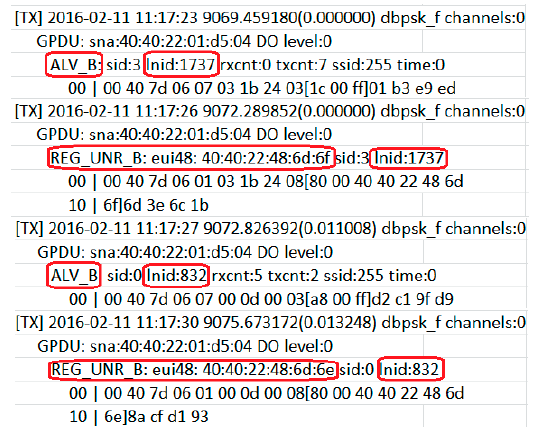
Figure 19. MAC traffic showing the last recorded Keep Alive messages and unregistration processes initiated by the BN for the SNs of the PV3 and the battery charger after the charger connection.